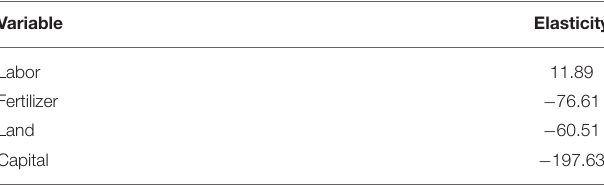
TABLE 8 | Factor demand elasticities with respect to crop diversification.